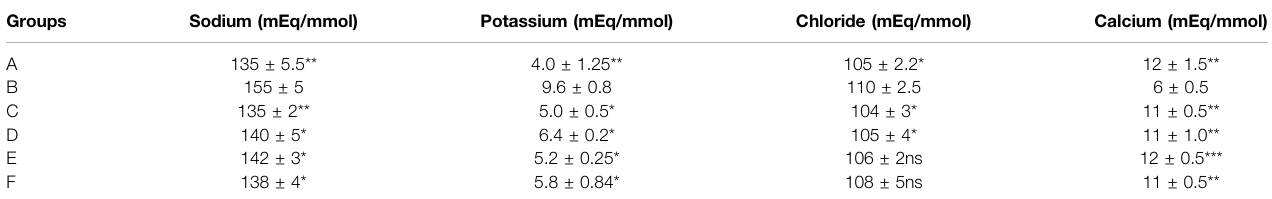
TABLE 2 | Levels of sodium potassium chloride and calcium levels: Group A (normal control), Group B (PTZ 25 mg/kg), Group C (LEV 21 mg/kg), Group D (kaempferol 21 mg/kg), Group E (quercetin 100 mg/kg), and Group F (catechin 100 mg/kg). Statistical analysis was done through one-way analysis of variance (ANOVA) trailed by Tukey ’ s post hoc test for all groups. The results are considered signi fi cant p if p < 0.005. pp p < 0.05 and ppp p < 0.05. Results were compared in a column with the respective diseased groups.